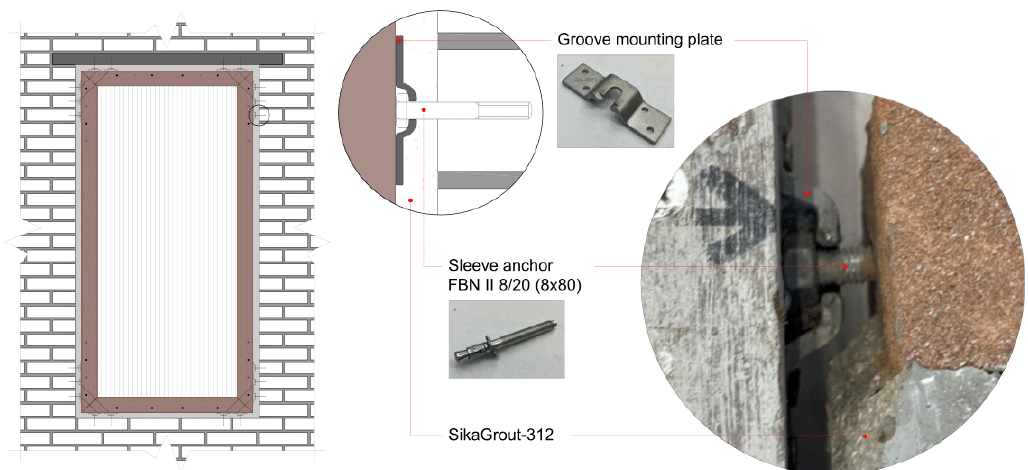
Figure 5. Window installation. The window is mechanically anchored to the masonry and concrete lintel and its perimeter is filled with grout.